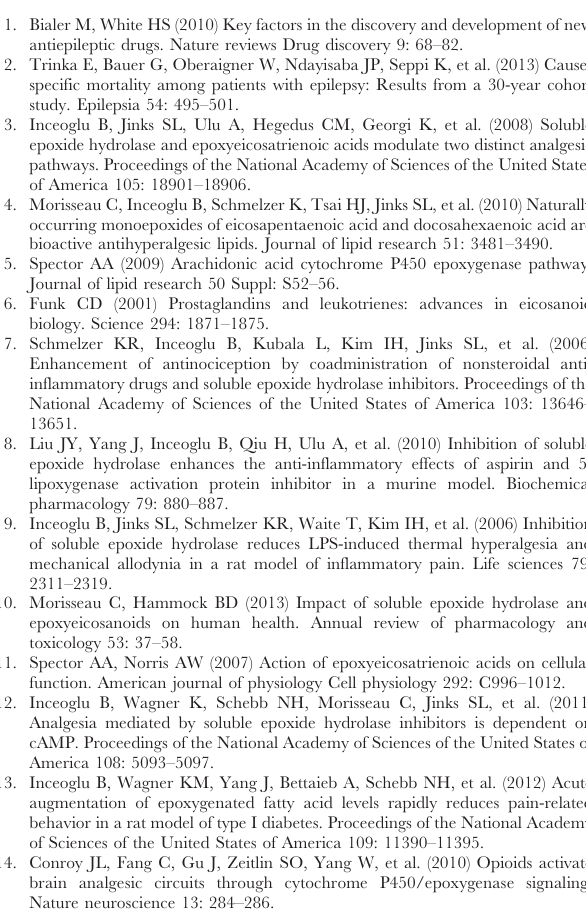
brain levels of sum of EpFAs and their corresponding dihydroxy- metabolites from ARA (8,9-EET, 11,12-EET and 14,15 EET), 17,18-EpETE) showed distinct patterns indicative of sEH dependent and independent mechanisms that selectively regulates their levels. (A) The sum of EET regioisomers remained unchanged in response to seizure but were elevated by inhibition of sEH with a concomitant decrease in the sum of corresponding dihydroxy- metabolites. (B) The sum of EpDPE regioisomers were decreased following seizures but were unchanged in response to inhibition of sEH. (C) The sum of EpETE regioisomers and their corresponding dihydroxy metabolites increased in response to seizure. While inhibition of sEH did not further elevate the EpETEs TUPS reduced the levels of the corresponding dihydroxy metabolites. (TIF) Figure S2 Brain levels of major prostanoids increase following tonic hind limb extension induced by PTZ and 4-AP. (A) In wild type and sEH 2 / 2 mice brain levels of major prostanoids display a highly similar profile in which PGE 2 , PGD 2 and PGF 2 a and PGJ 2 are elevated to the same degree. This data suggests brain sEH had no role in modulating the levels of prostanoids in the brain after seizures. (B) Parallel results are obtained with small molecule inhibitor of sEH. (C) Seizure induced by 4-AP also led to an increase in prostanoids although